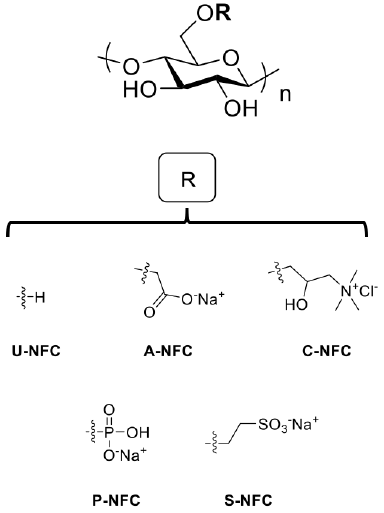
Figure 1. Chemical structures of the nanofibrillated cellulose (NFC) materials under study.